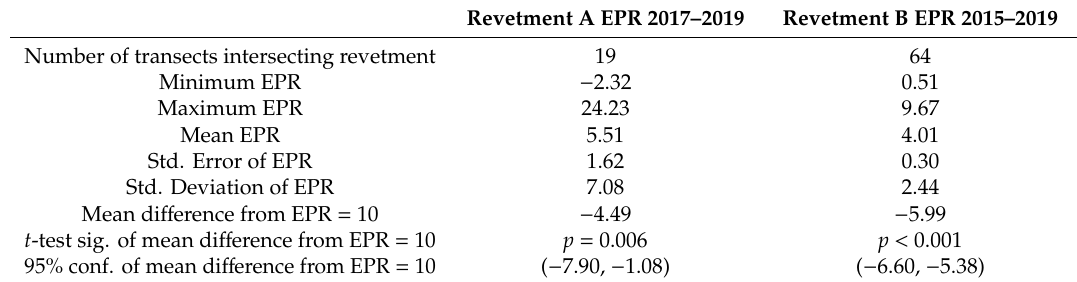
Table 8. End Point Rate (EPR) in m / y after revetment installation (positive indicates erosion).